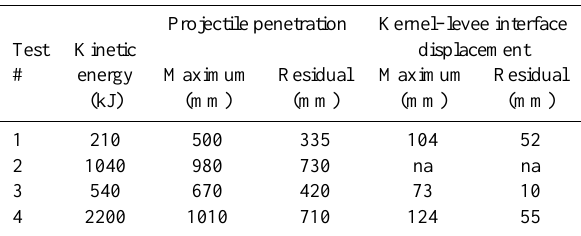
Figure 15. After the fourth impact, the sandwich wall exhibited a different deformation pattern from one plane to the other. Cracks, compaction and bulking were observed in the levee. Table 2. Sandwich structure deformation at the impact height (na: not